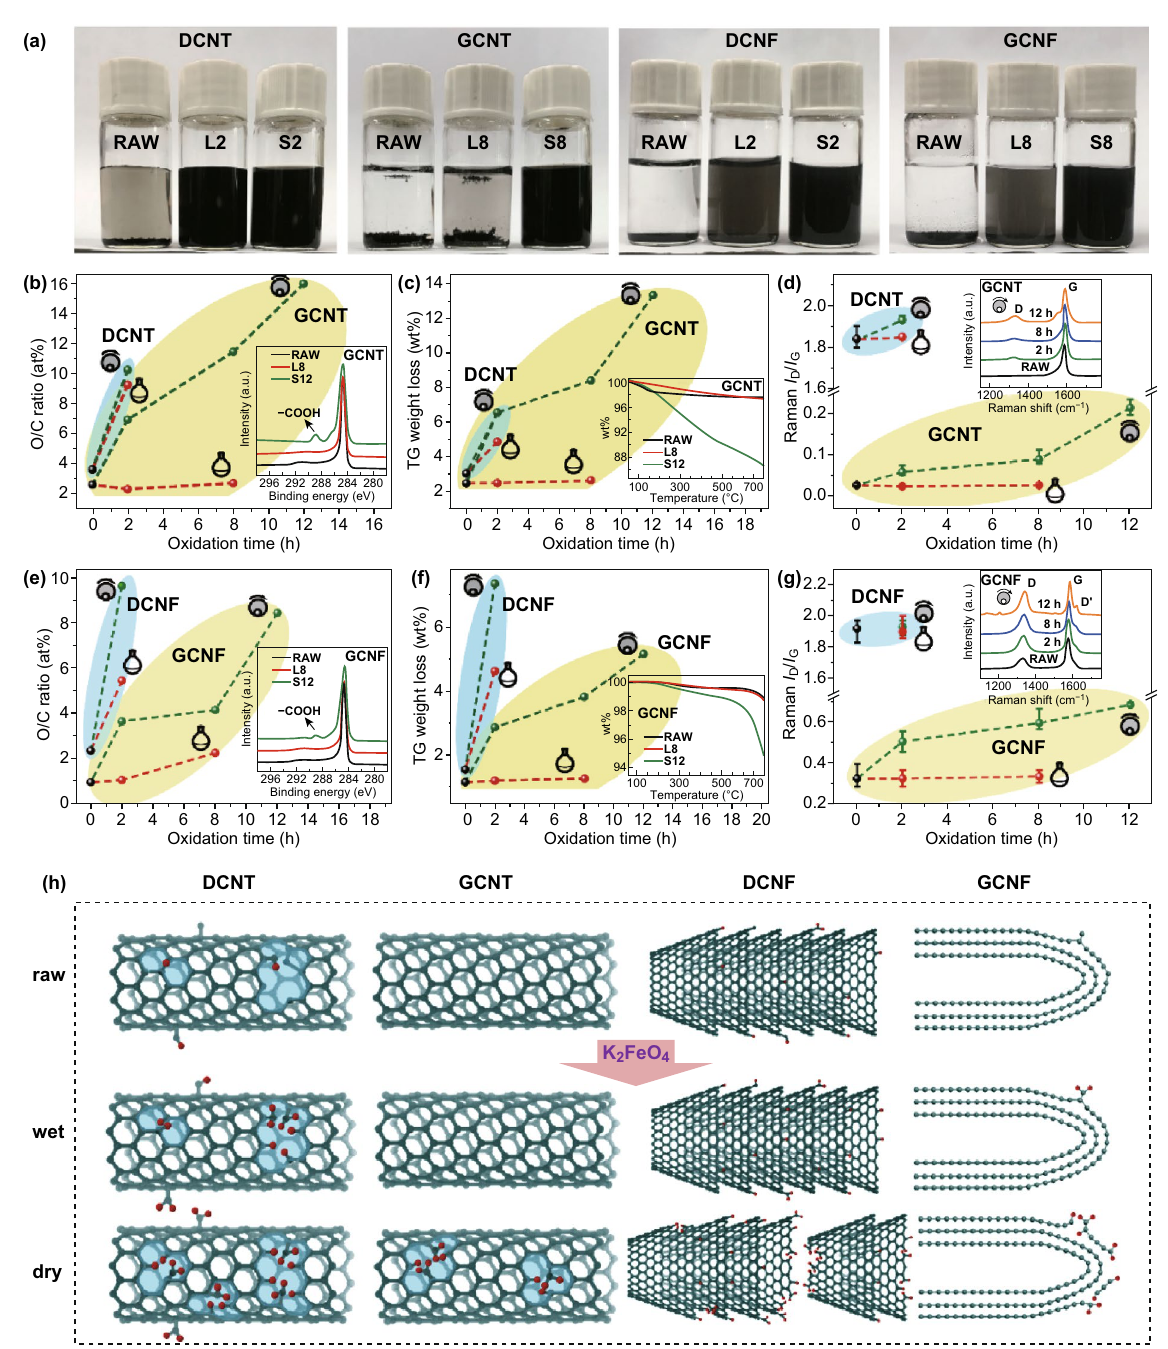
Fig. 3 Oxidation results of various nanocarbons by K 2 FeO 4 in liquid phase and solid state. If applicable, water‑dispersible portions of the prod‑ ucts were isolated for measurements to better show the oxidation effects. a Photographs of 0.1 mg mL −1 samples in water that had been soni‑ cated for 5 min and settled for 3 days. b , e XPS O/C ratios (inset: representative C 1s spectra). c , f TG weight losses (inset: representative TG curves). d , g I D / I G ratios (inset: representative Raman spectra). h A depiction of the effects of K 2 FeO 4 oxidation on nanocarbons in liquid phase and solid state (oxygen atoms are shown in red). (Color figure